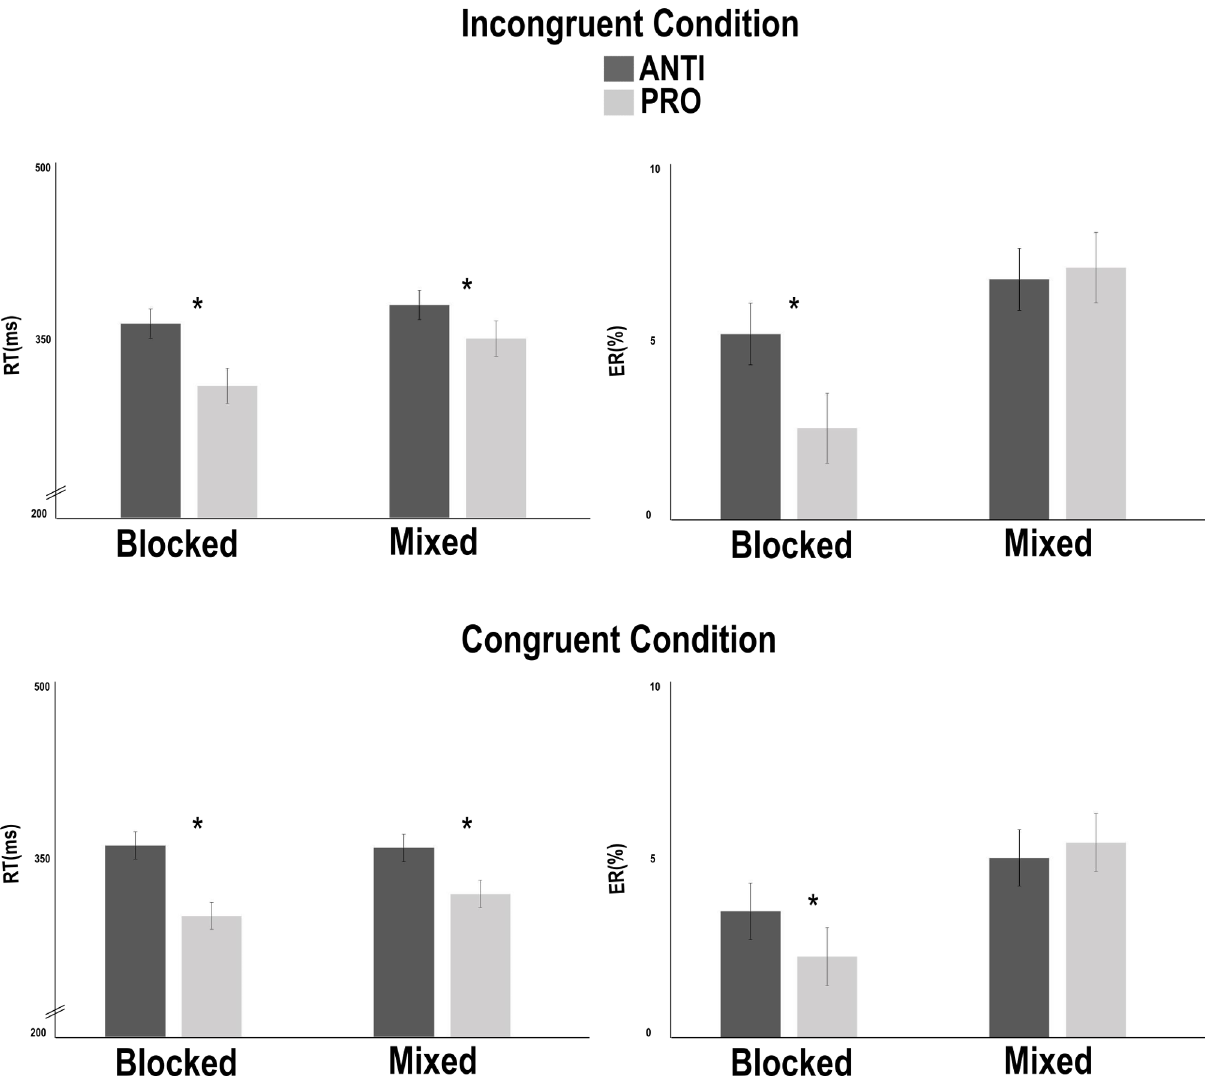
Fig 5. Results of the modified version of the anti-saccadetask in the changed-gaze condition. Switchingx response-suppression interactionin incongruentand congruenttrials. The results showedthat in the blockedcondition, the differencesin RTs and error rates (ERs) between ANTI and PRO conditionswere greater than in mixed condition.